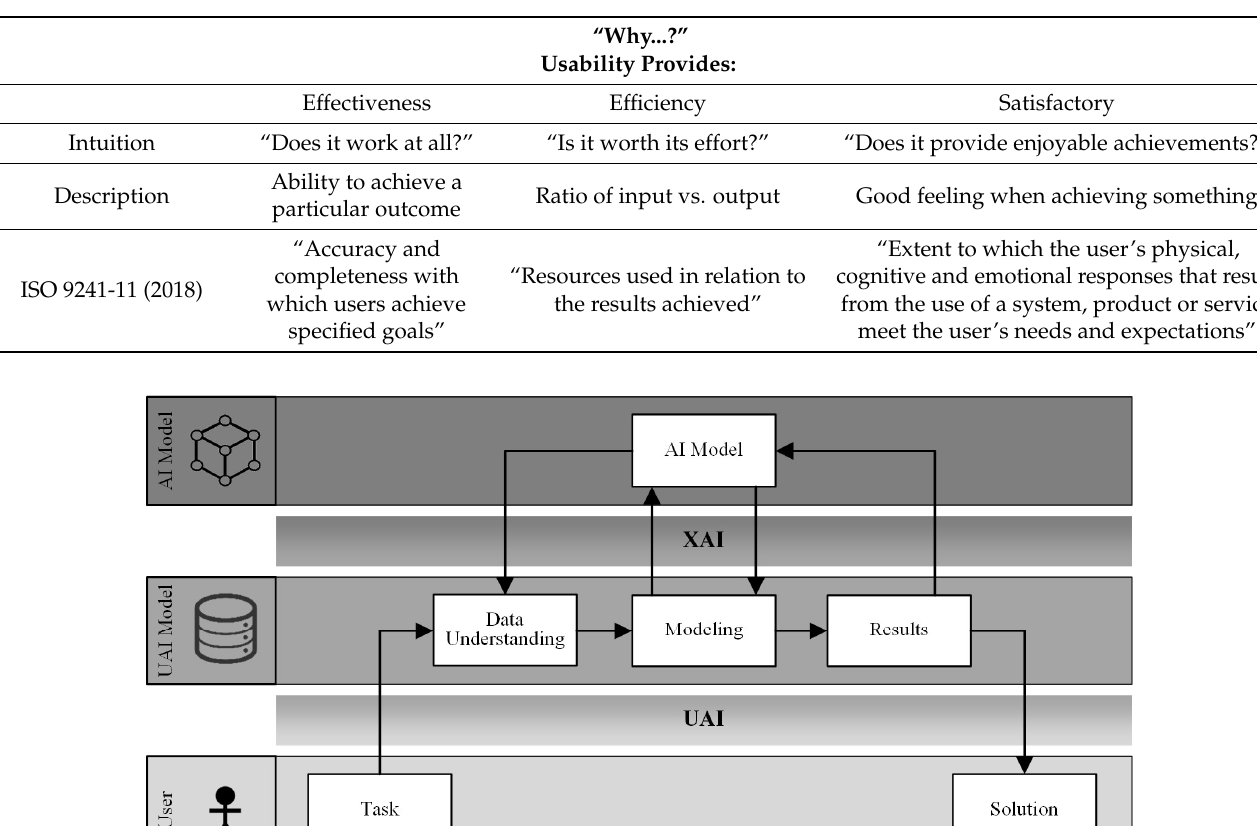
Table 2. Definition of usability characteristics.